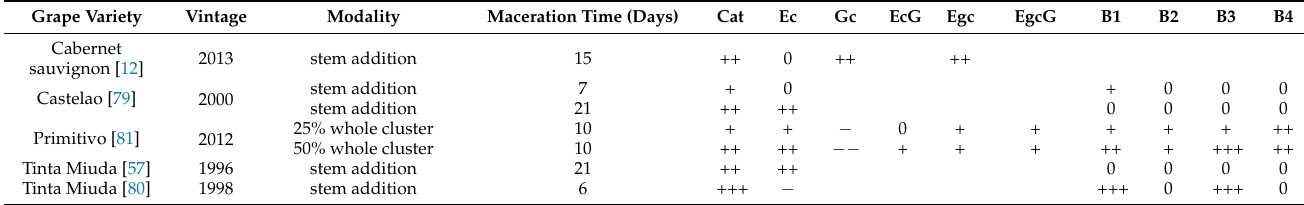
Table 18. Impact of stems during winemaking on flavan-3-ol monomeric and polymeric composition. Grape